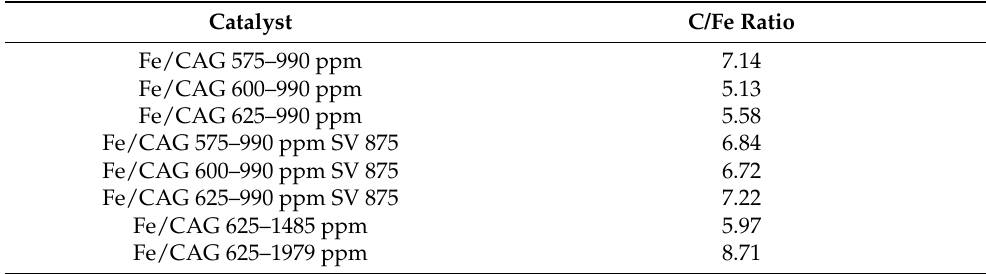
Table 1. C/Fe ratio of spent catalysts at different toluene concentrations in the inlet. Elements detected by electron microscopy–energy dispersive X-ray spectroscopy (SEM–EDX). The space velocity of the experiments was 700 mL/(min g cat ) except when another value is